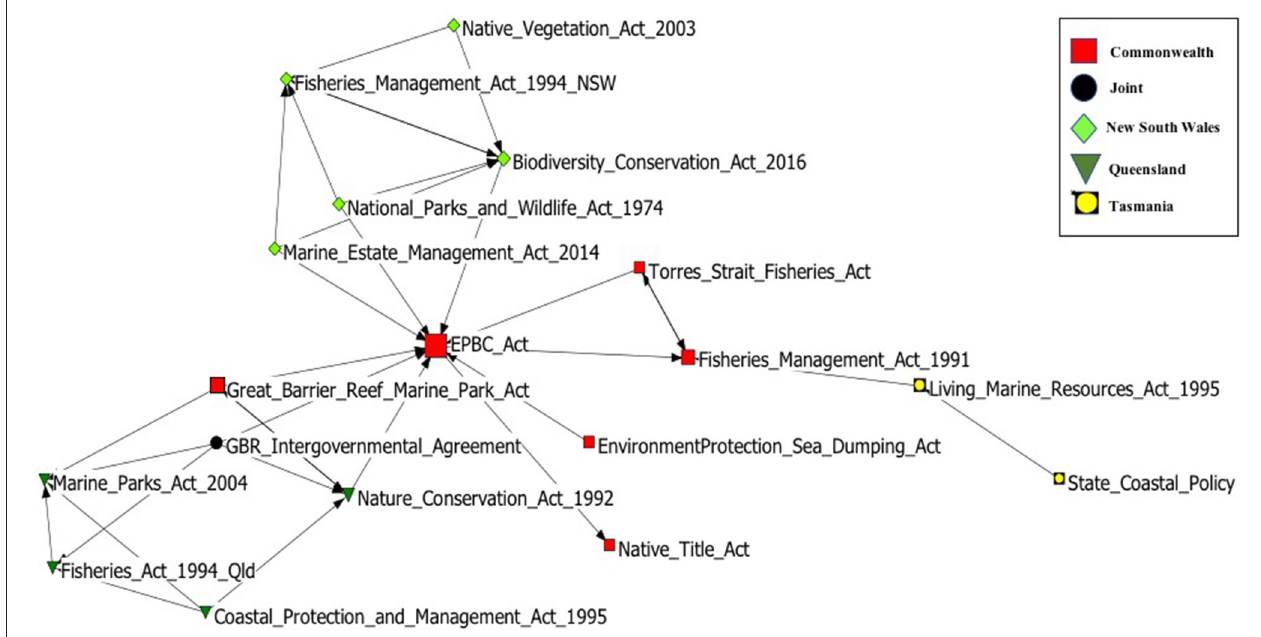
FIGURE 3 | The connectedness of environmental policies from multiple levels of governance (symbols represent location) in Australia. Reviewed Victorian legislation is excluded as no policies connected with the reviewed policies of any other jurisdiction or within Victoria. Node position is based on centrality within the network; the EPBC Act 1999 has the most connections and is the central link for policies within Australia. Node size is based on betweenness – larger nodes serve as a pathway for more policies. Relationships between policies are directional—the arrow points from one policy to another where a relationship has been